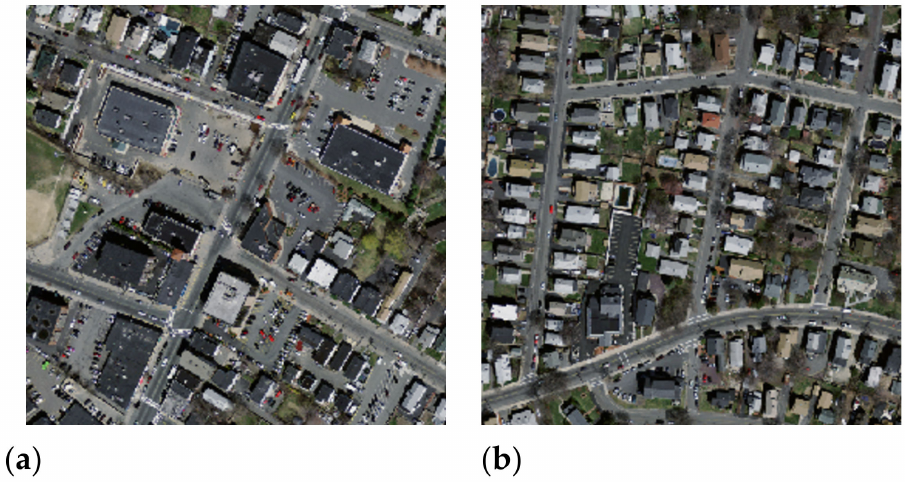
Figure 6. These are the two characteristics of the Massachusetts Buildings Dataset: ( a ) The diversity of this building style; ( b ) the density of this building